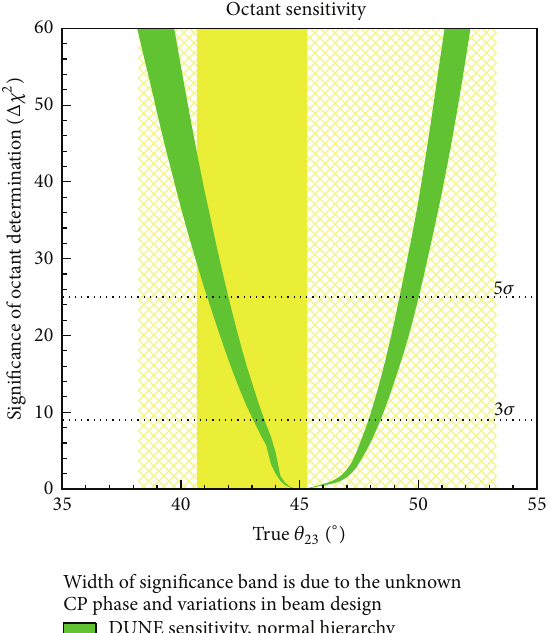
Figure 6: This figure shows the sensitivity with which the quadrant of 𝜃 23 can be determined using the LBNF beam as a function of its true value. The green shaded region shows the range due to variations in beam design and the true value of 𝛿 region shows the current best fit value for NO from a global fit from the NuFit